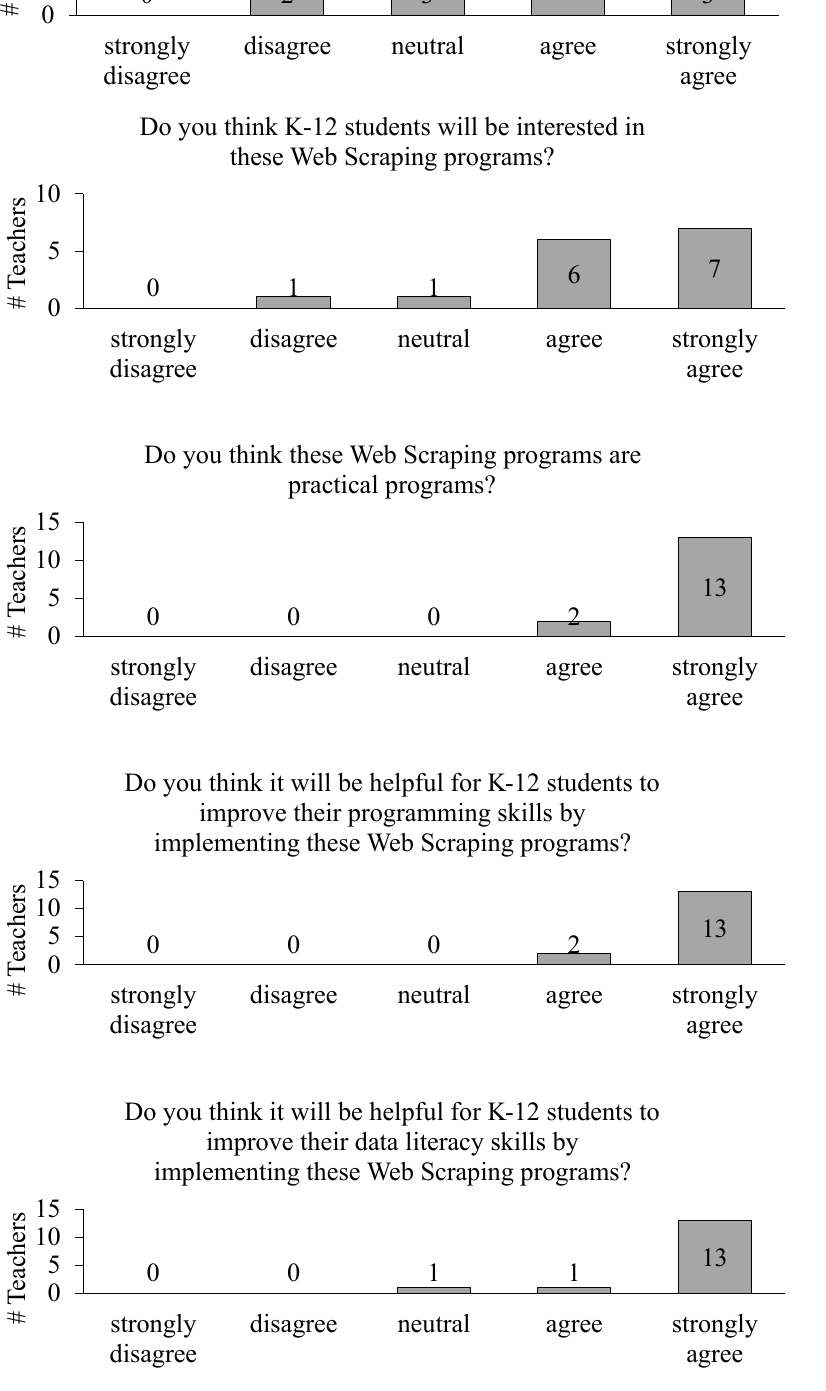
Figure 10. The teachers’ evaluation results for the proposed programming blocks from the five